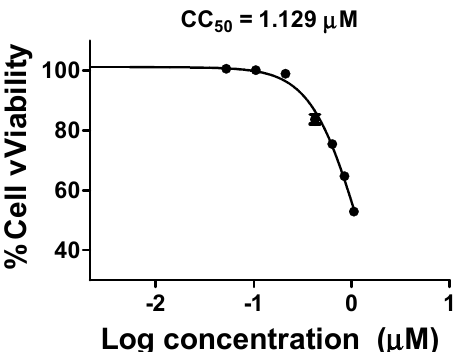
Figure 5. Cytotoxic activities of M3. The cytotoxic activity of M3 compound was tested on normal human cells at different concentrations (0.105, 0.211, 0.422, 0.632, 0.843, and 1.054 µM). The data display the mean of cell viability percentage ± SEM of 3 replicas.